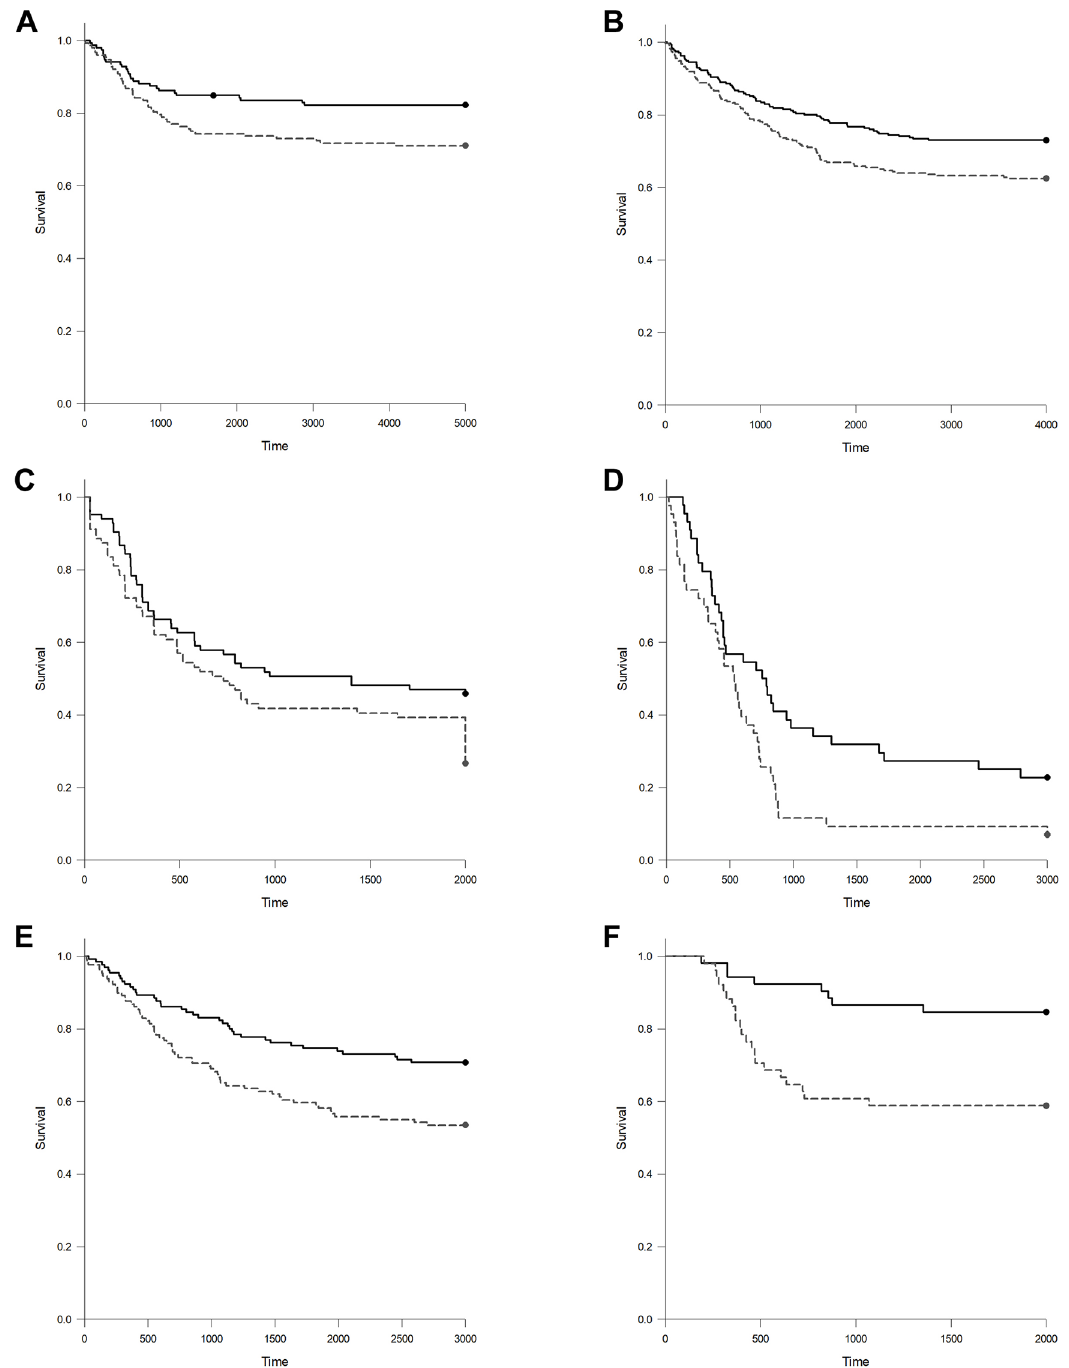
Fig 3. Patients with high levels of DNMT3B7 expression have lower survival rates than those with low expression levels. The median DNMT3B7 expression for each individual tumor was determined to divide patients with that tumor into “high” (gray, dotted line) and “low” (black, solid line) expression groups. Kaplan-Meier curves were generated and statistical significance was determined for (A) CESC, p = 0.025; (B) KIRC, p = 0.009; (C) LAML, p = 0.035; (D) MESO, p = 0.013; (E) SARC, p = 0.003; and (F) SKCM, p =